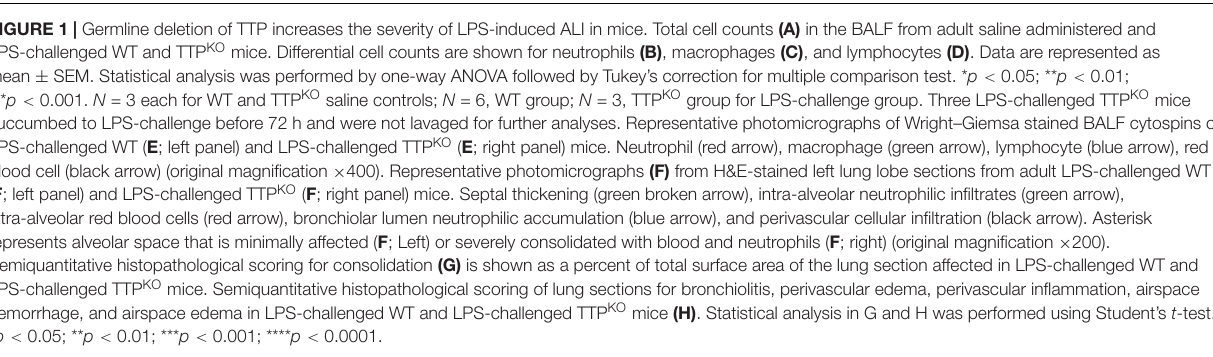
FIGURE 1 | Germline deletion of TTP increases the severity of LPS-induced ALI in mice. Total cell counts (A) in the BALF from adult saline administered and LPS-challenged WT and TTP KO mice. Differential cell counts are shown for neutrophils (B) , macrophages (C) , and lymphocytes (D) . Data are represented as mean ± SEM. Statistical analysis was performed by one-way ANOVA followed by Tukey’s correction for multiple comparison test. * p < 0.05; ** p < 0.01; *** p < 0.001. N = 3 each for WT and TTP KO saline controls; N = 6, WT group; N = 3, TTP KO group for LPS-challenge group. Three LPS-challenged TTP KO mice succumbed to LPS-challenge before 72 h and were not lavaged for further analyses. Representative photomicrographs of Wright–Giemsa stained BALF cytospins of LPS-challenged WT ( E ; left panel) and LPS-challenged TTP KO ( E ; right panel) mice. Neutrophil (red arrow), macrophage (green arrow), lymphocyte (blue arrow), red blood cell (black arrow) (original magnification × 400). Representative photomicrographs (F) from H&E-stained left lung lobe sections from adult LPS-challenged WT ( F ; left panel) and LPS-challenged TTP KO ( F ; right panel) mice. Septal thickening (green broken arrow), intra-alveolar neutrophilic infiltrates (green arrow), intra-alveolar red blood cells (red arrow), bronchiolar lumen neutrophilic accumulation (blue arrow), and perivascular cellular infiltration (black arrow). Asterisk represents alveolar space that is minimally affected ( F ; Left) or severely consolidated with blood and neutrophils ( F ; right) (original magnification × 200). Semiquantitative histopathological scoring for consolidation (G) is shown as a percent of total surface area of the lung section affected in LPS-challenged WT and LPS-challenged TTP KO mice. Semiquantitative histopathological scoring of lung sections for bronchiolitis, perivascular edema, perivascular inflammation,